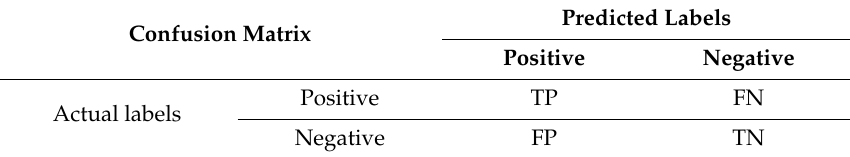
Table 2. Confusion